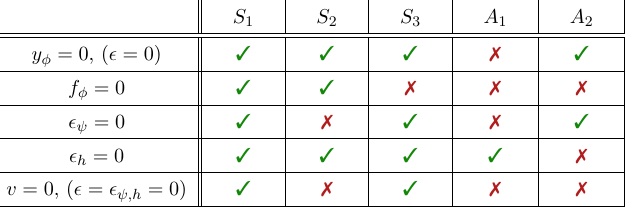
Table 2 . Presence ( 3 ) or absence ( 7 ) of bubble diagrams for specific limits. See figure 3 for the diagrammatic definition of S